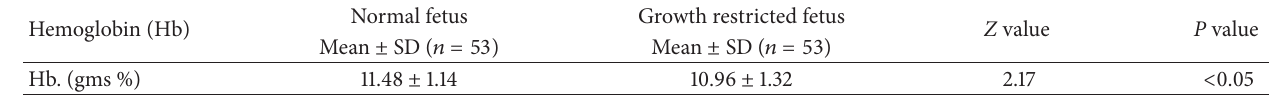
Table 2: The comparison of hemoglobin (Hb) in study groups.